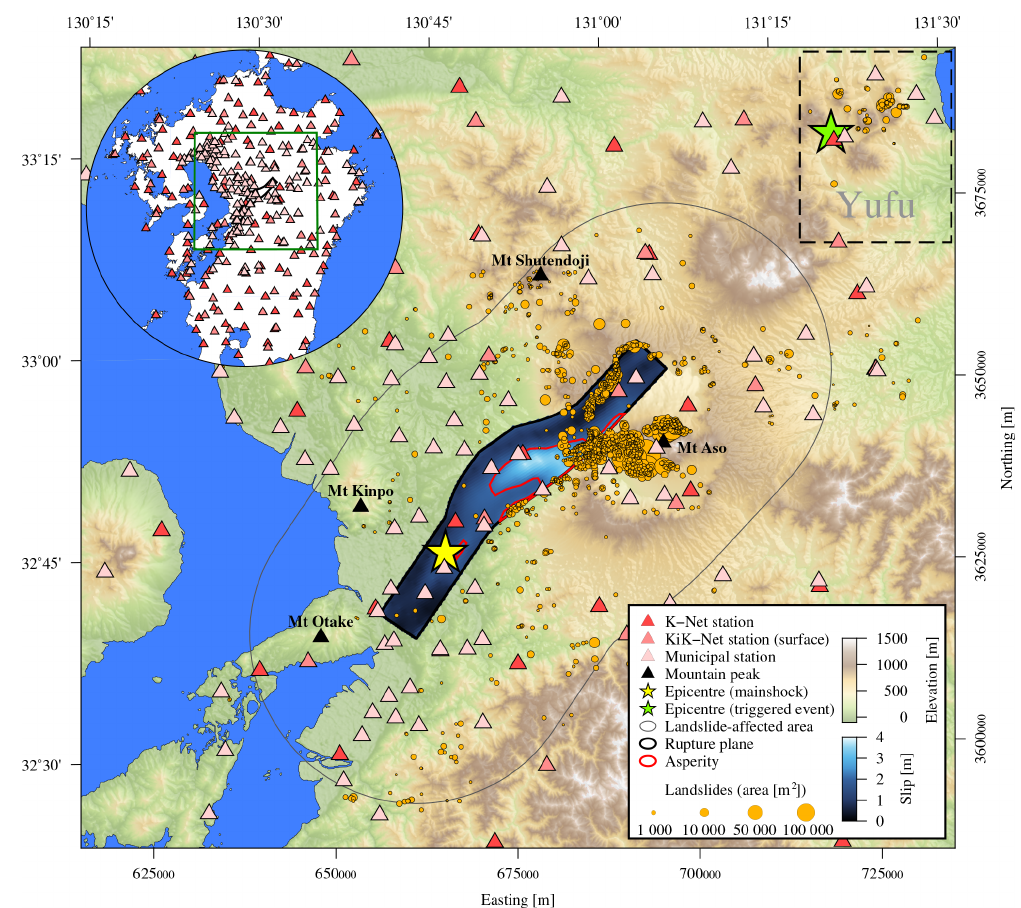
Figure 1. The area of Kyushu affected by coseismic landslides triggered by the 2016 M w 7.1 Kumamoto earthquake. The coloured patch is the slip distribution of the rupture model by Kubo et al. (2016), and the dashed box encompasses landslides related to the triggered event in Yufu (epicentre location after Uchide et al. (2016)). The inset map shows the station network within 150km of the